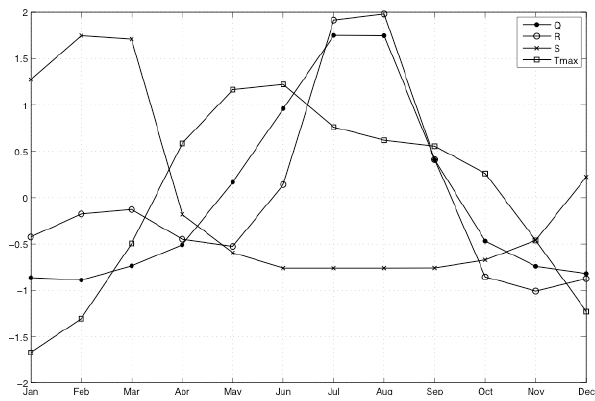
Fig. 3. Comparison of the seasonality of total inflow and basin climatology ( Q = normalized inflow, R = normalized rainfall, S = normalized snow, T max =normalized maximum